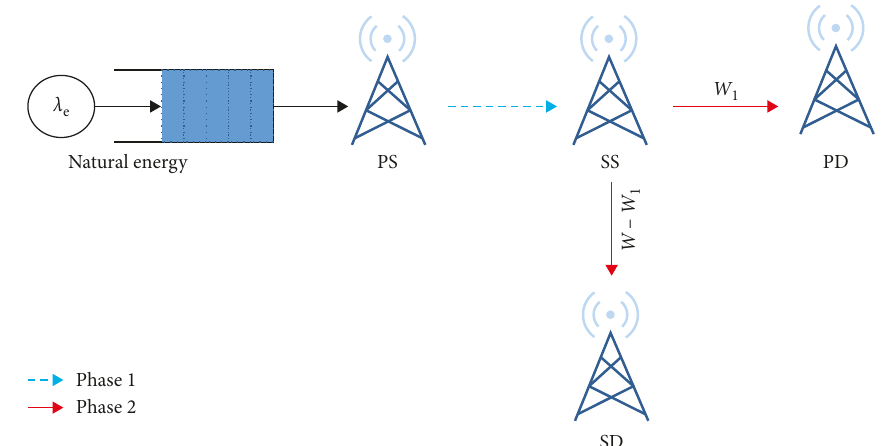
Figure 1: System model of the energy harvesting and relaying protocol for the cognitive relay